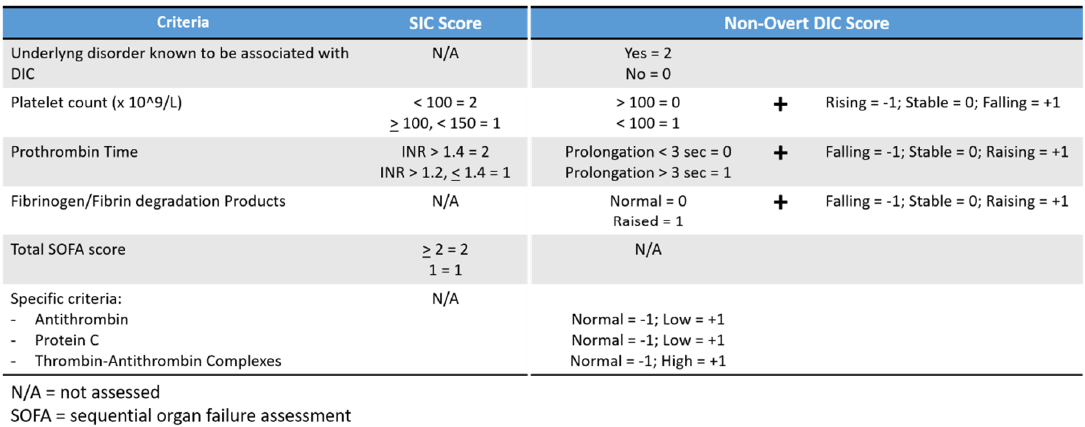
Figure 1. The screening of coagulopathy (SIC) and the non-overt disseminated intravascular coagulation (DIC) scoring systems